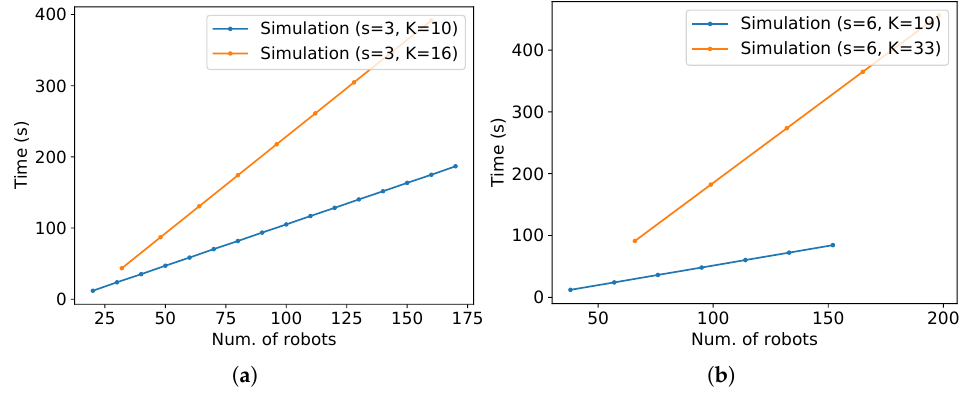
Figure 41. Time of arrival at the target of the last robot versus number of robots for the same simulations in Figure 40. ( a ) s = 3 m and K ∈ { 10,16 } ; ( b ) s = 6 m and K ∈ { 19,33 }